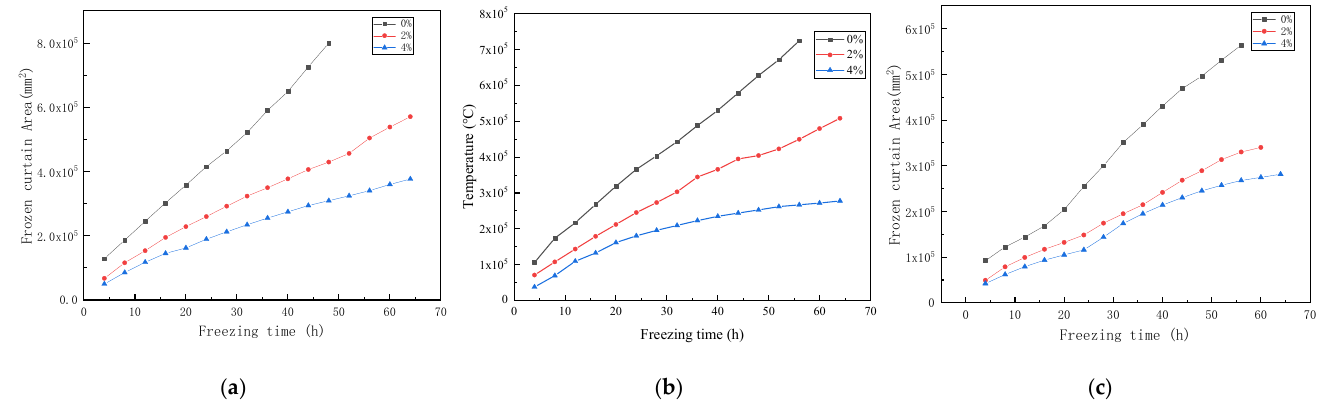
Figure 15. The relation between freezing curtain area and freezing time at ( a ) 0 m/d; ( b ) 3 m/d; ( c ) 6 m/d. Table 6. The average development rates of frozen curtain area (unit: mm 2 /h).